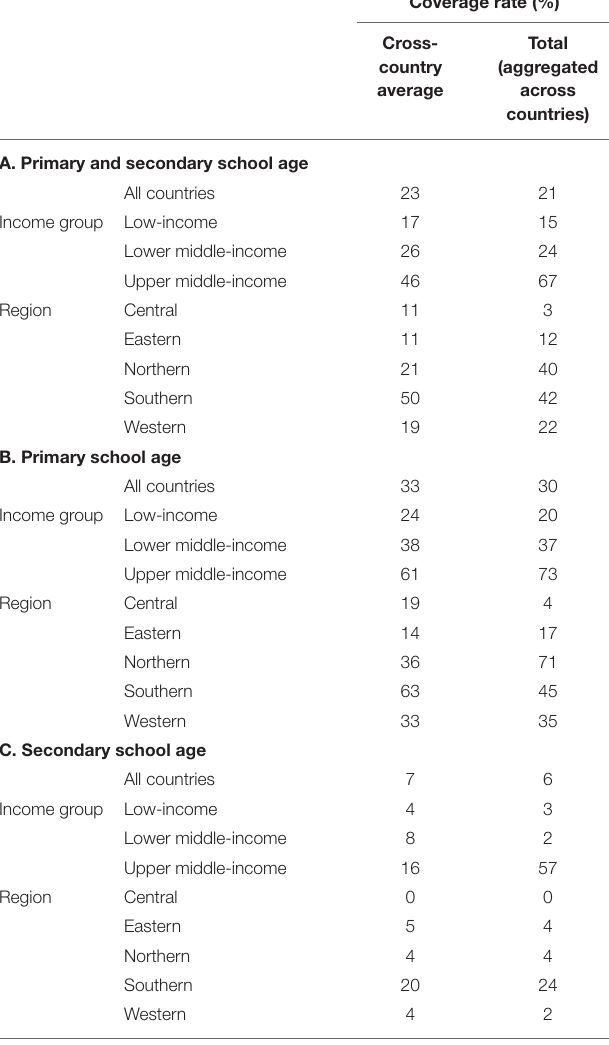
TABLE 1 | School feeding coverage rates (percent of school-age children receiving food).